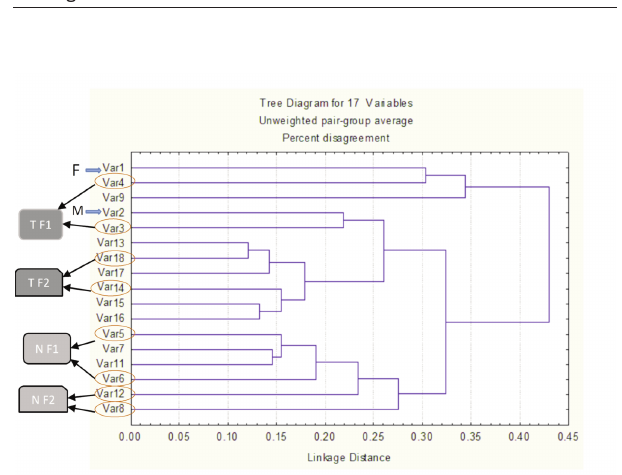
Fig. 1 - UPGMA dendrogram showing genetic relationships among 17 DNA samples of unirradiation and irradiation of P. operculella. Samples are: 1. Female, 2. Male, 3-4. F1 irradiated males, 5-6. F1 unirradiated males, 8-12. F2 unirradiated males, 7. Mix DNA samples of F2 irradiated males 8-12, 18-14, 13. Mix DNA samples of F2 irradiated males 14-18.